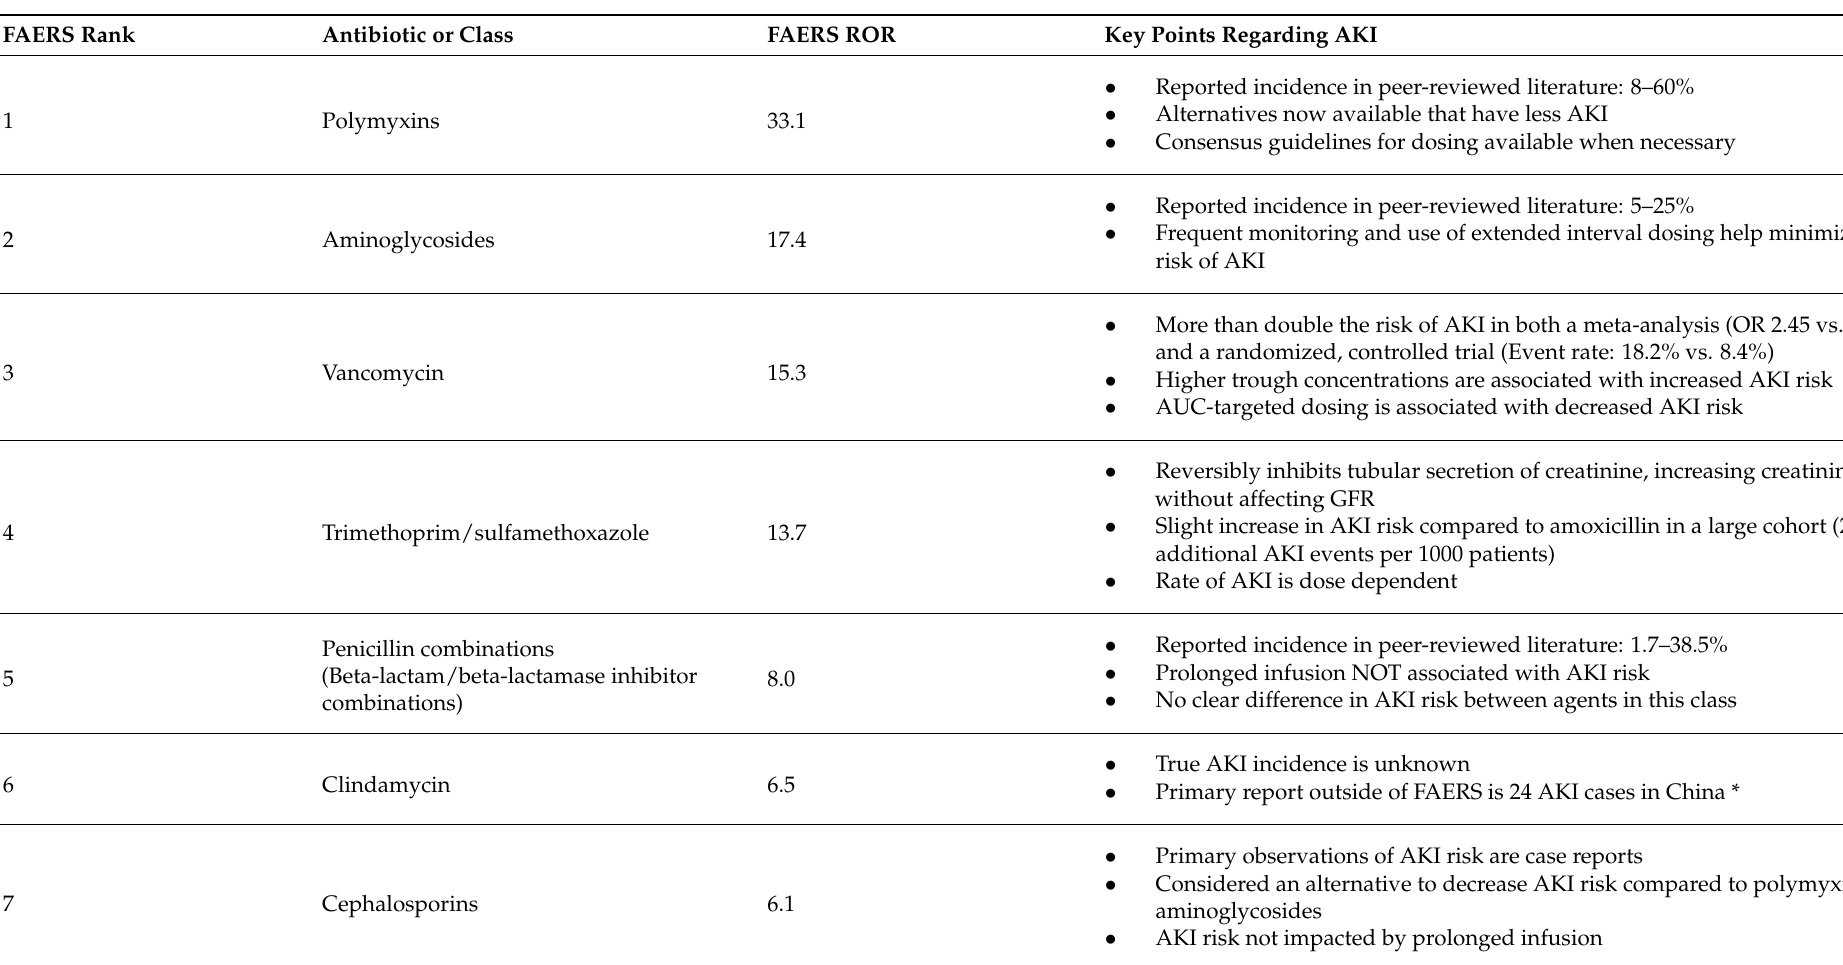
Table 3. Summary of clinical data for antibiotics with highest AKI signals in